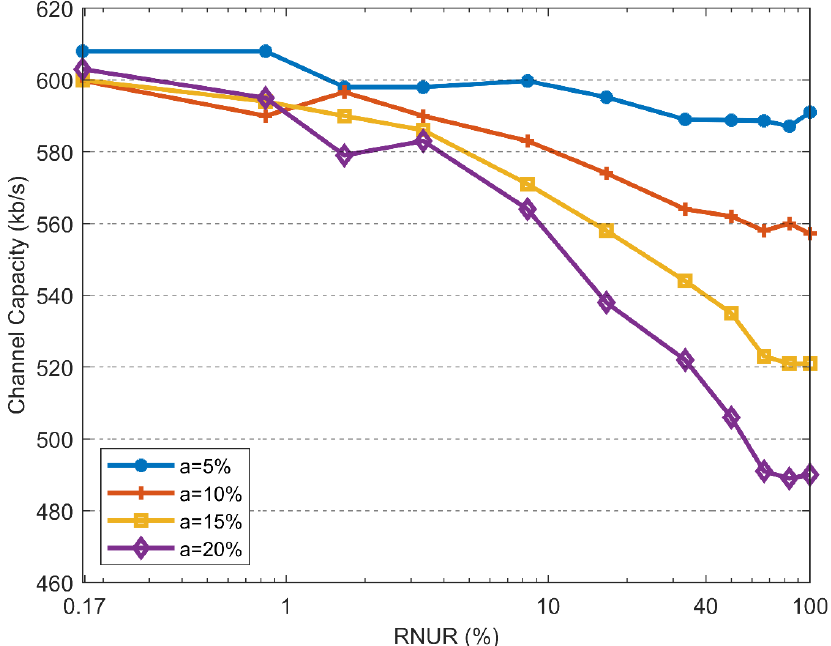
Figure 12. Channel Capacity of the G3 PLC measured with different values of the RNUR and the modulation index of the RPPM modulated DC ‐ DC converter at 60 kHz switching frequency.